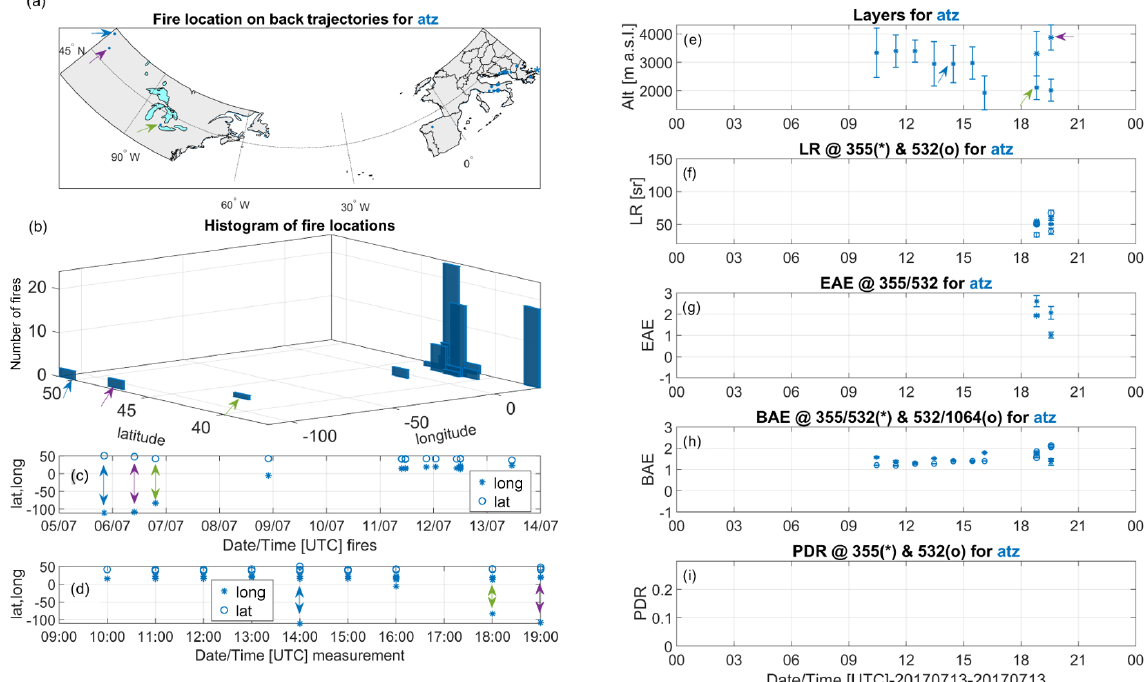
Figure 9. LRT as measured at Athens (“atz”) on 13 July 2017. (a) Locations of the fires. (b) Histogram of the fire occurrence in each geographical grid. The North American fires are marked by arrows. (c) Fire coordinates versus fire occurrence time. (d) Fire coordinates versus measurement time. (e) Smoke layer altitude. Layers measuring LRT smoke are marked by arrows. The first two smoke layers are considered “mixed” and the third (magenta) “pure NA”. (f–i) Intensive